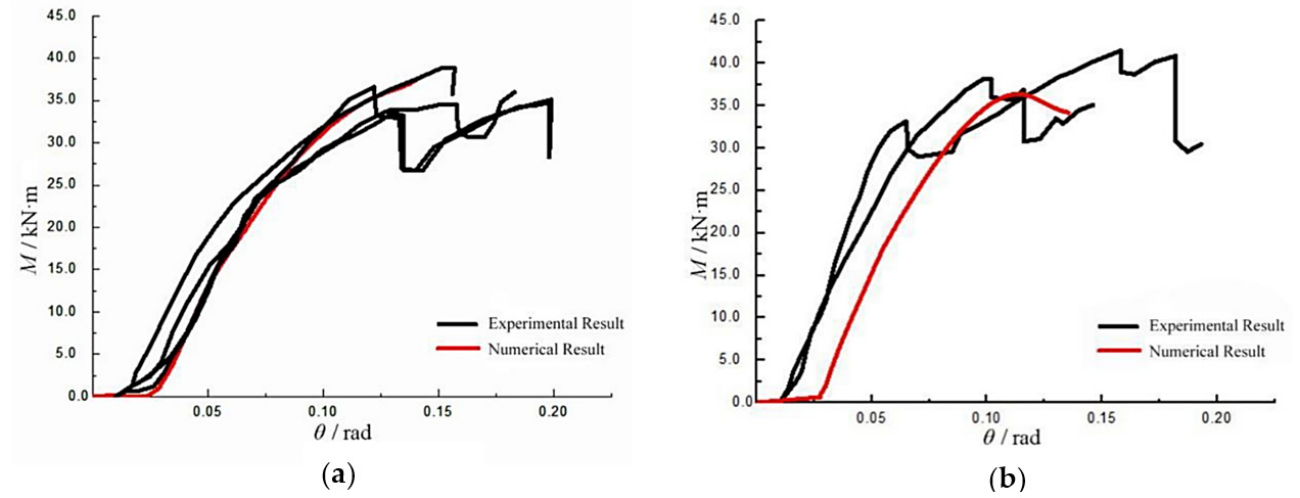
Figure 12. Moment–rotation curve: ( a ) model 1 (d = 20 mm) and ( b ) model 2 (d = 24 mm), adapted from